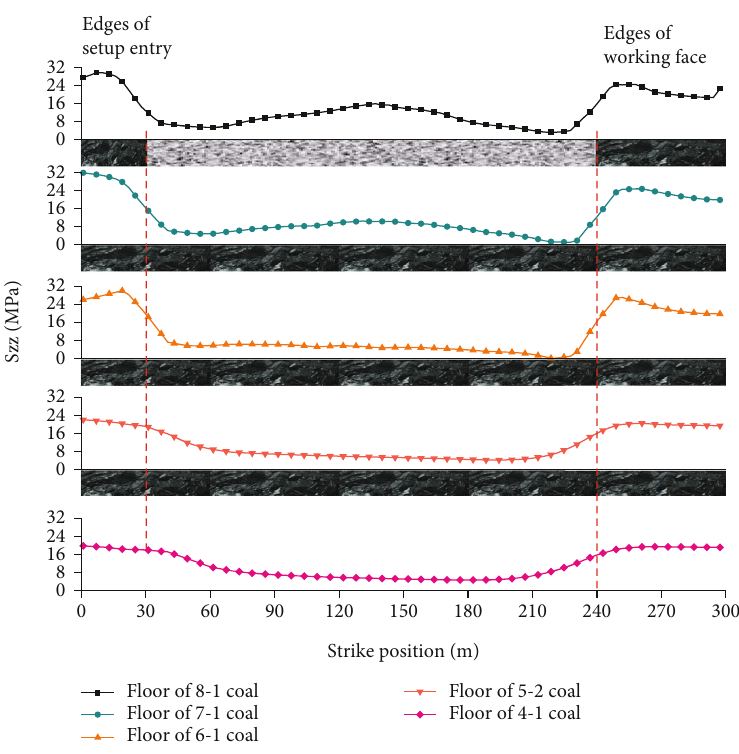
Figure 6: Stress distribution curves along the strike after the 8-1 coal seam